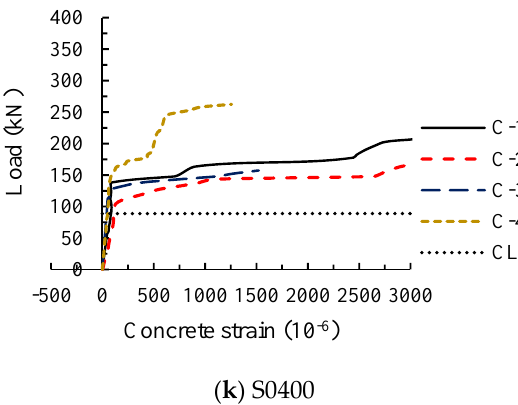
Figure 6. Load-concrete strain curves of specimens (CL: cracking load). ( a ) Beam S0000; ( b ) Beam S0005; ( c ) Beam S0010; ( d ) Beam S0015; ( e ) Beam S0020; ( f ) Beam S0300; ( g ) Beam S0305; ( h ) Beam